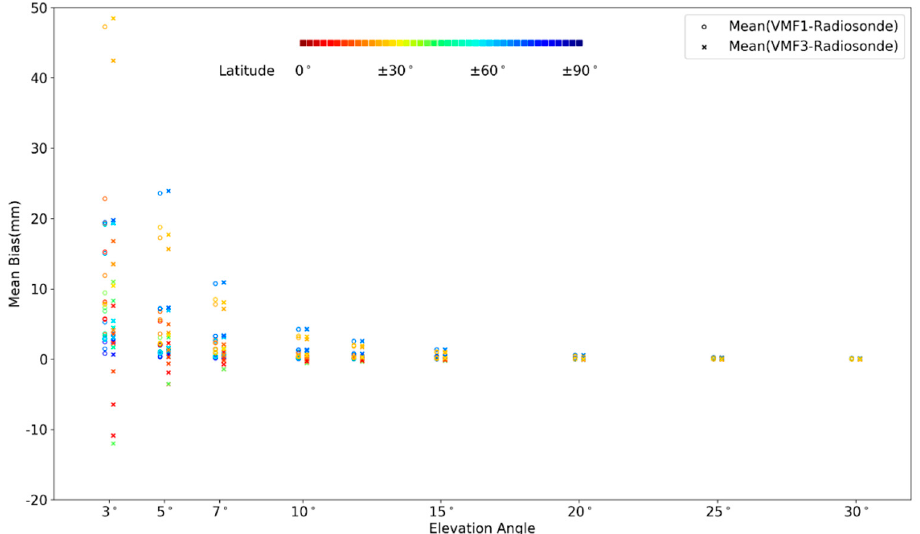
Figure 13. Mean biases of VMF3 / VMF1 SWD with respect to radiosonde SWD estimates from ray-tracing in mm. Cross marks stand for VMF3 SWD biases, and circle marks stand for VMF1 SWD biases (they are plotted with small a horizontal shift to avoid covering). The color bar indicates the station latitudes.